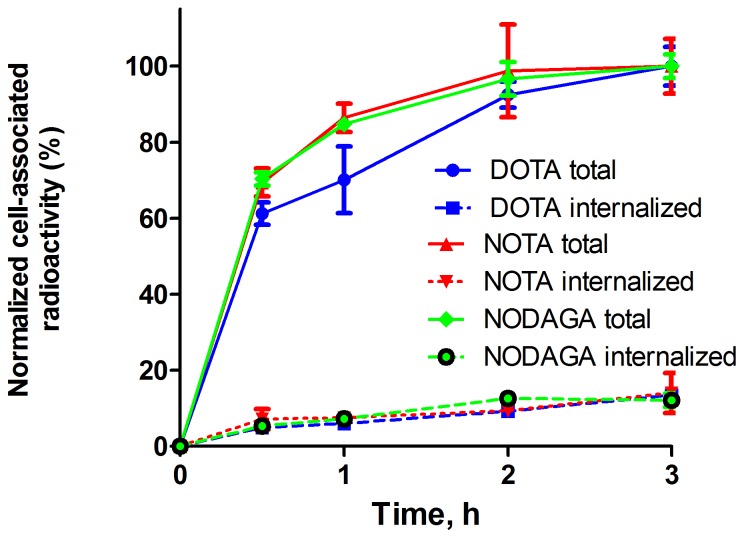
Cellular processing of 68Ga-NODAGA-ZHER2:S1, 68Ga-NOTA-ZHER2:S1 and 68Ga-DOTA-ZHER2:S1 by HER2-expressing cells SKOV-3 in vitro.Cells were incubated with labeled compound at 37°C. Cell bound activity is normalized to the maximum uptake. Data are presented as mean values for three cell dishes and standard deviations. Error bars might be smaller than the symbols.